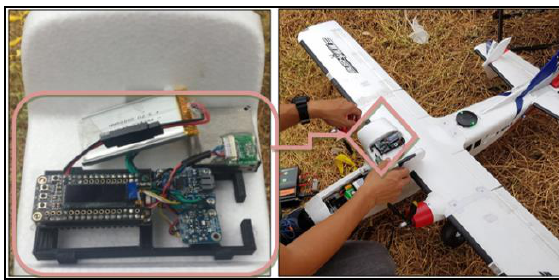
Figure 9. Integrated Air Quality Sensor and lightweight fixed- wing UAV (Photos taken during